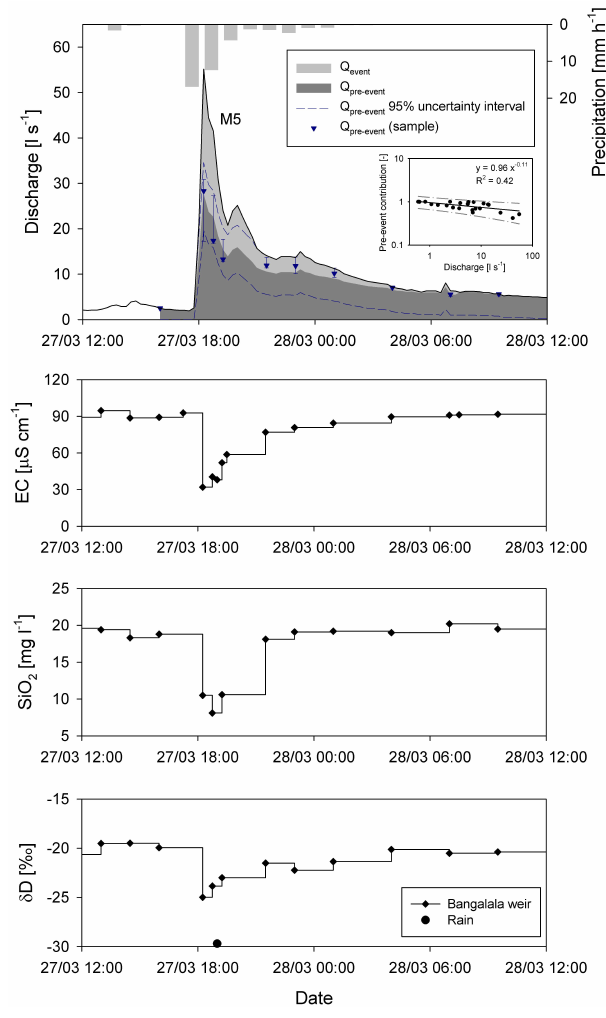
Fig. 6. The top plot shows the hydrograph separation between event ( Q e ) and pre-event ( Q p ) runoff for the M5 event (27/03/08, WS2) Figure 6: The top plot shows the hydrograph separation between event (Q e ) and pre-event 3 based on combined δD , EC and SiO 2 measurements in the Mataini (Q p ) runoff for the M4 and M5 (26-27/03/08) events (WS2) based on combined δ D, EC and 4 catchment. The bold black line ( - ) shows the total discharge ( Q tot ) , SiO 2 measurements in the Mataini catchment. The bold black line (-) shows the total 5 the two grey shaded areas represent the central estimates for the discharge (Q tot ), the two grey shaded areas represent the central estimates for the event ( (cid:1) ) 6 ) and pre-event ( event ( and pre-event ( (cid:1) ) contributions derived from a power relationship between relationship 7 tionship between relationship between Q tot and Q p , which is shown between Q tot and Q p , which is shown in the inset (cf. Godsey et al., 2009), and the dashed line 8 in the inset (cf. Godsey et al., 2009), and the dashed line ( (--) is the corresponding 95% uncertainty interval. The circle symbols ( ● ) denote Q p for the 9 individual analyzed samples, with the whiskers representing the 95% uncertainty interval. The 10 corresponding 95% uncertainty interval. The circle symbols ( 3 bottom plots show the available tracer data for M4 and M5. 11 note Q p for the individual analyzed samples, with the whiskers rep- resenting the 95% uncertainty interval. The 3 bottom plots show 38 the available tracer data for M4 and